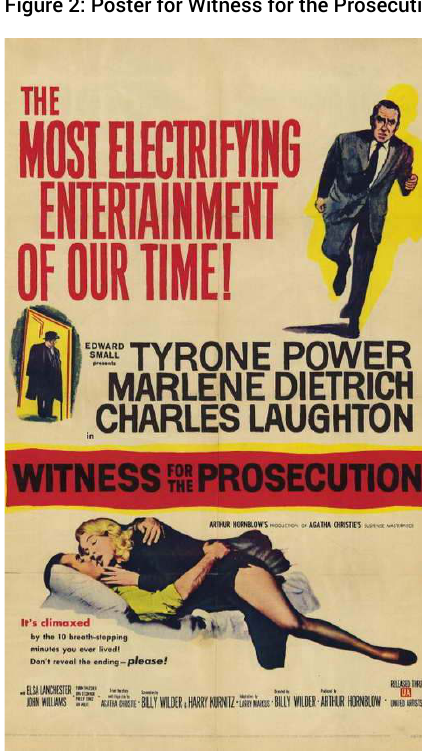
Figure 2: Poster for Witness for the